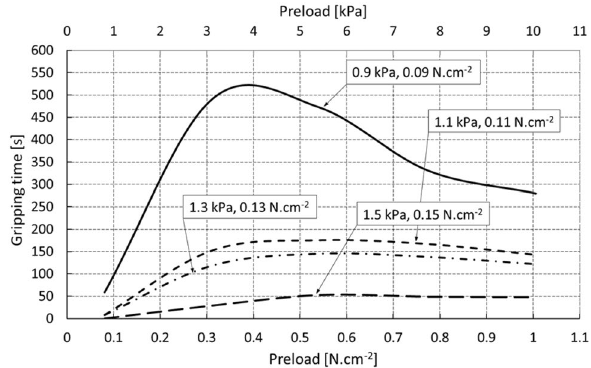
Fig. 10 Gripping time of the object depending on the degree of pressure and load of the gripping element (the data in the boxes are for each curve)